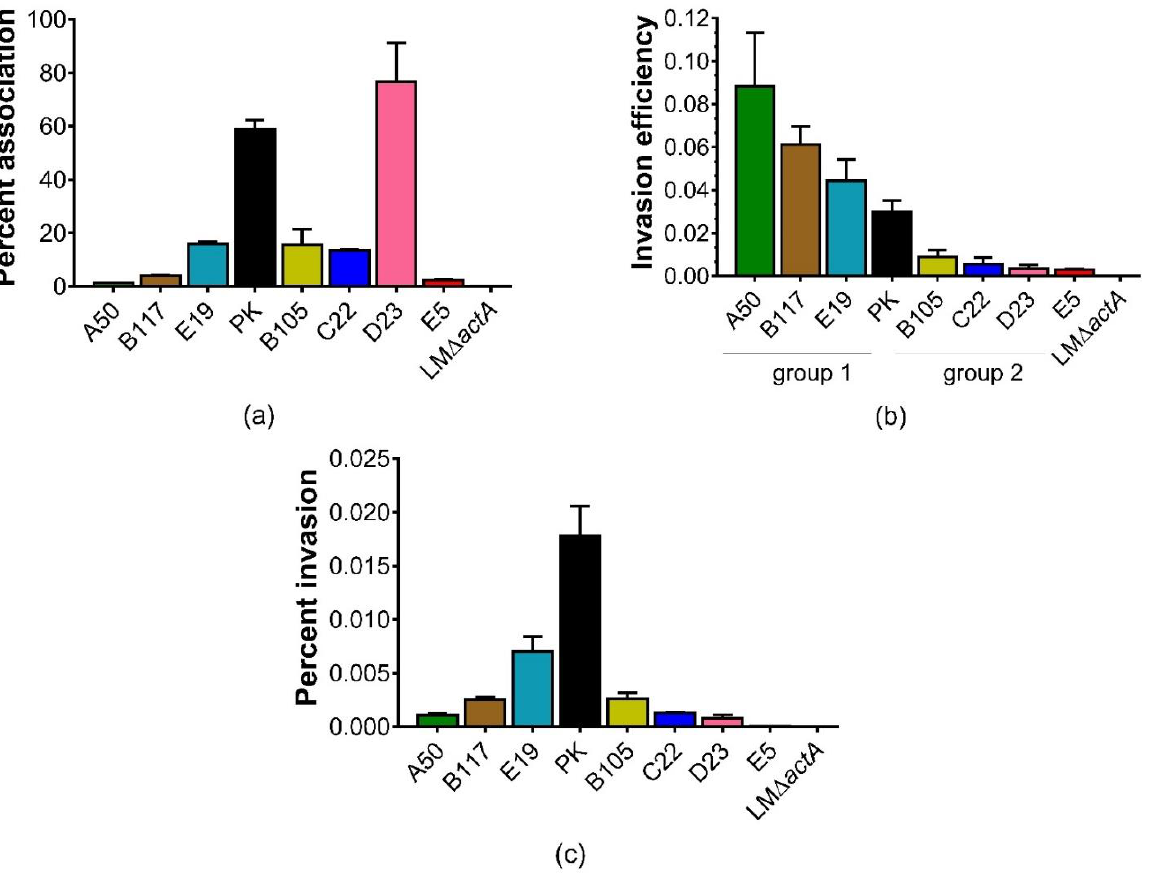
Figure 2. Percentage of cell association ( a ), invasion efficiency ( b ), and percentage of cell invasion ( c ) of various isolates of Group B Streptococcus (GBS). Differentiated Caco-2 cell monolayers were infected with GBS for 2 h at a multiplicity of invasion (MOI) of 10. The percent cell association is the number of associated bacteria (adhered and invaded cells) divided by the actual number of inoculated bacteria multiplied by 100. The invasion efficiency is calculated by the number of invaded bacteria (after 2 h of antibiotic treatment) divided by the number of associated bacteria (before antibiotic treatment) multiplied by 100. The percent cell invasion is the number of invaded bacteria divided by the actual number of inoculated bacteria multiplied by 100. Data on the Y axis are reported as the average number from three independent experiments with standard error bars. Assays were performed in triplicate. Listeria monocytogenes Δ act A (LM Δ act A) was used as a negative control.